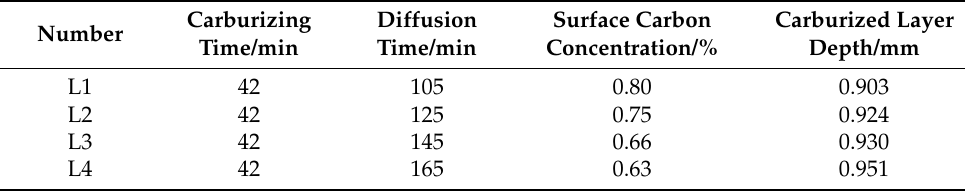
Table 4. Carbon concentration at different diffusion times.